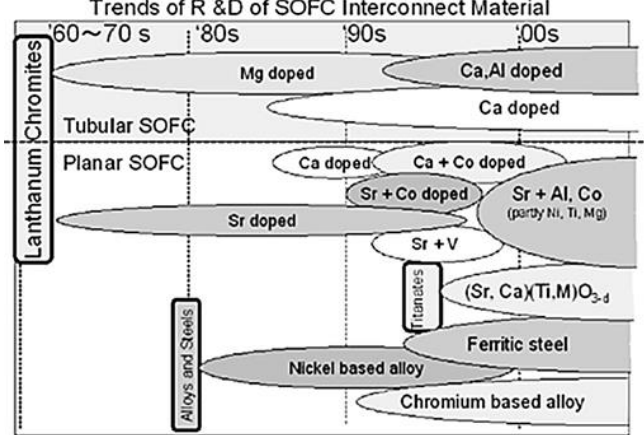
Figure 7 Figure 7. Trend in R&D of SOFC interconnect materials